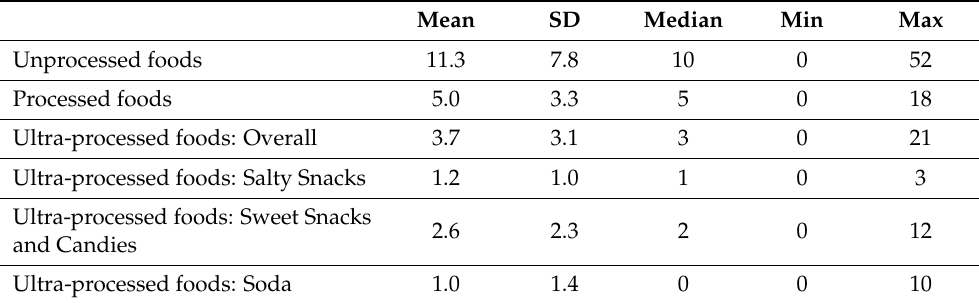
Table 2. Food items available at home for low-income overweight or obese pregnant women (N =